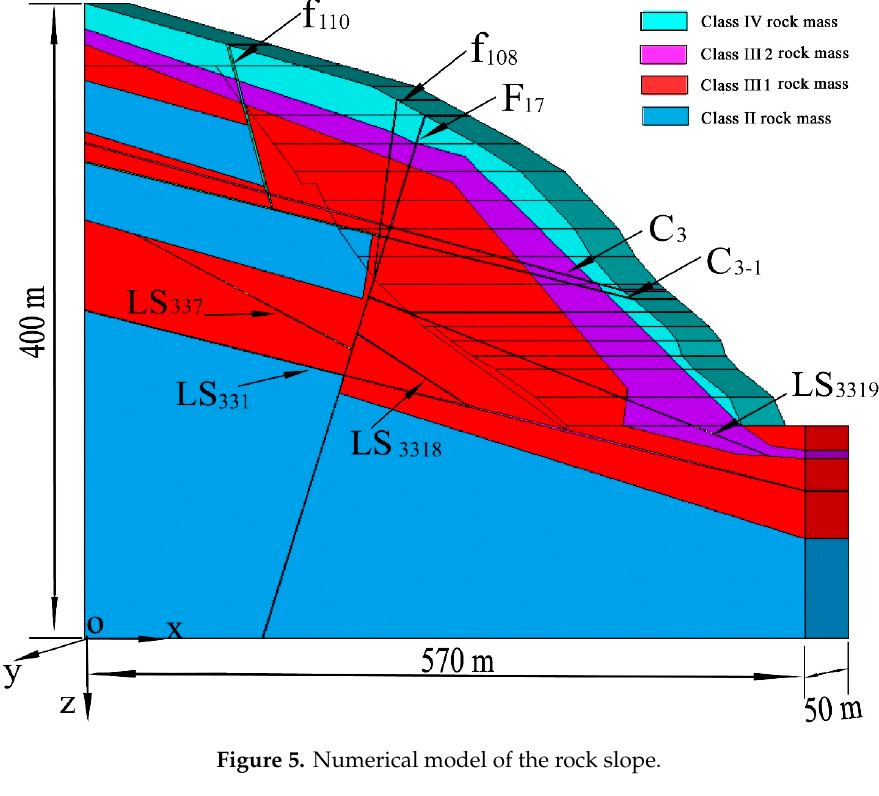
Figure 5. Numerical model of the rock slope.